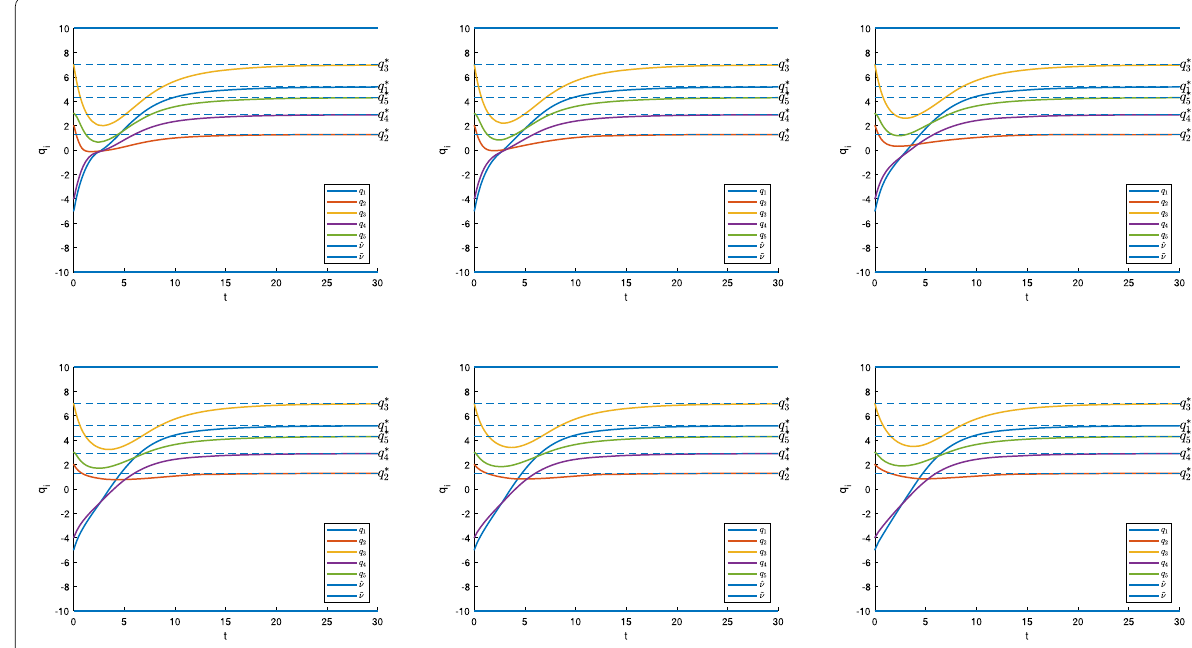
Figure 13 The output power trajectories with different control gains γ i